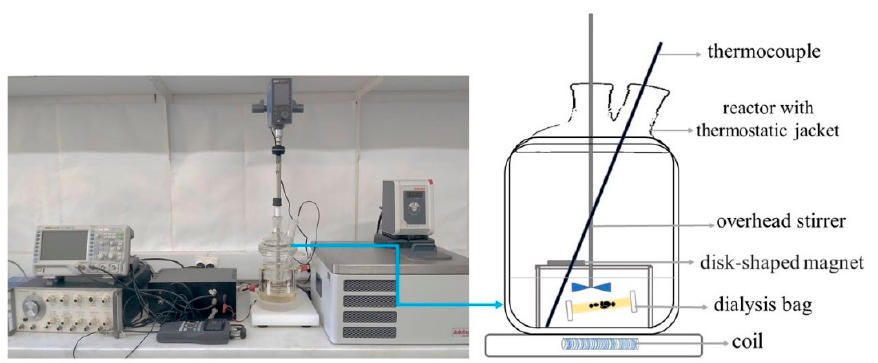
Figure 2. Experimental setup of the release kinetics and schematic illustration of a reactor. The drug release was calculated by measuring the absorbance of quercetin released in the supernatant at λ = 330 nm by the UV-Vis spectrophotometer. The releasing kinetics of quercetin from magnetite MNPs was investigated at three temperatures (25 °C, 30 °C and 37 °C) in the mixture PBS/EtOH (vol. 50/50) in which the solubility of quercetin totals to 5.66 mg/mL, 5.83 mg/mL and 6.02 mg/mL at 25 °C, 30 °C and 37 °C, respectively [38 ] .